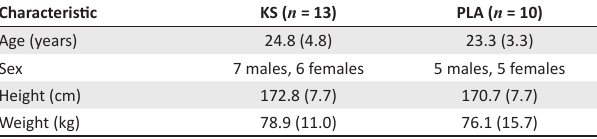
FIGURE 1: Flow diagram demonstrating number of participants recruited, enrolled and analysed. TABLE 1: Baseline values for participants in the ketone salt and placebo